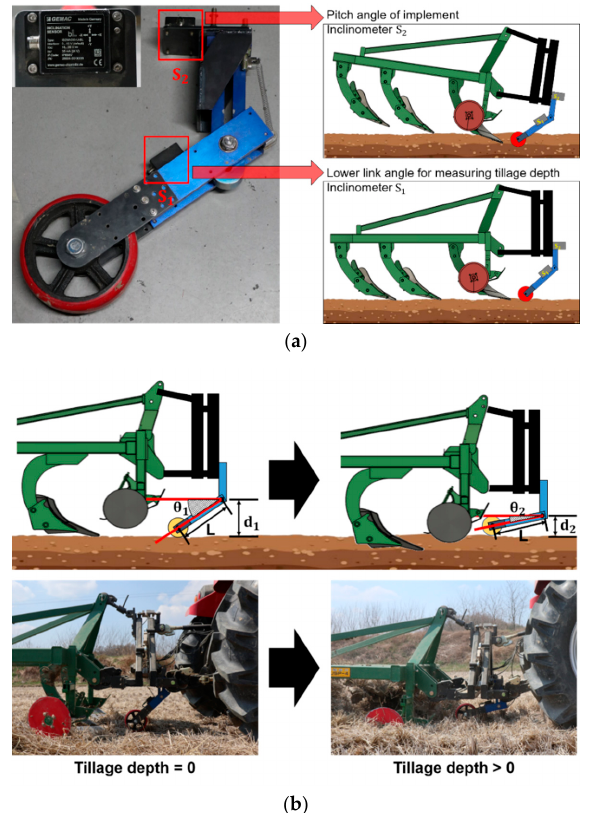
Figure 4. ( a ) Configuration of the tillage depth measurement system and ( b ) measurement principle of the tillage depth measurement system during tillage operation.